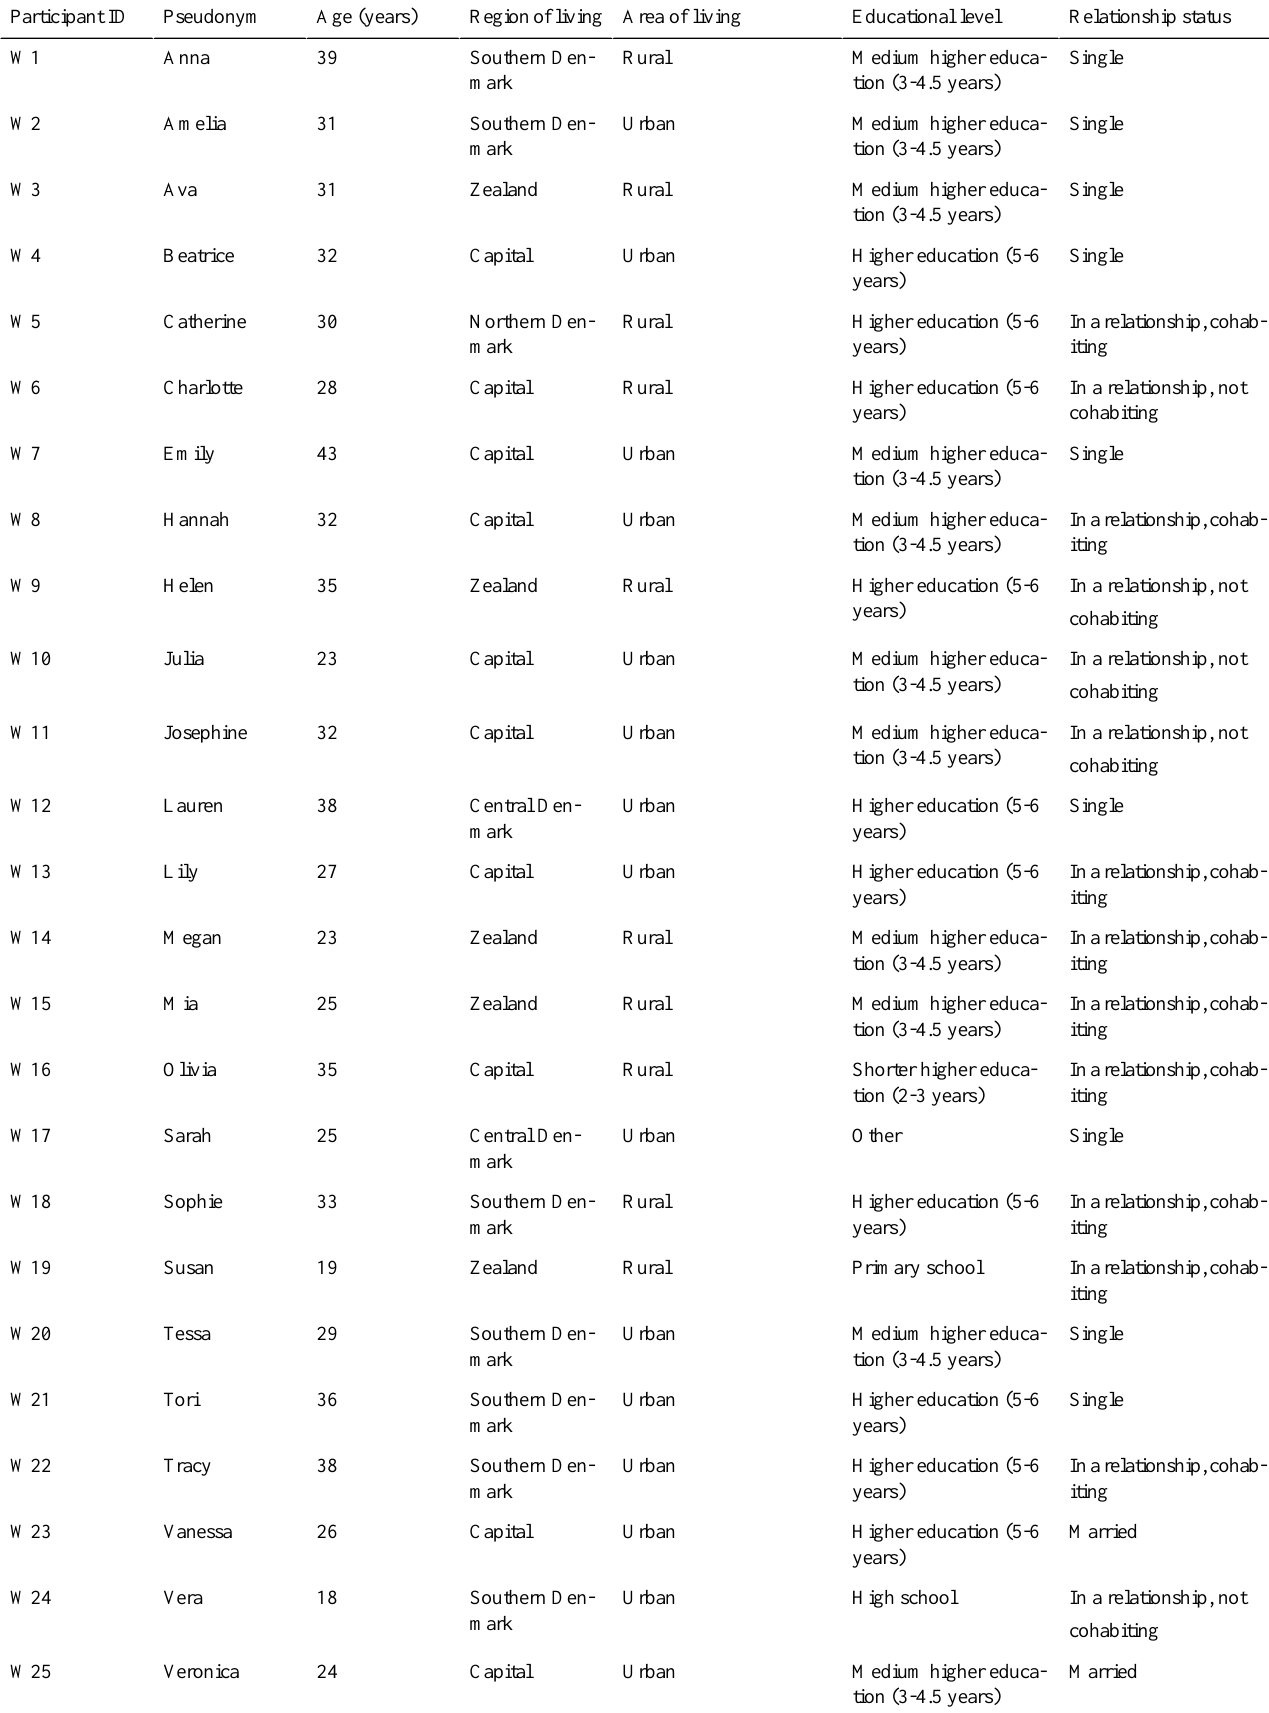
Table 1. Demographics of the women of reproductive age included in the online focus groups in this